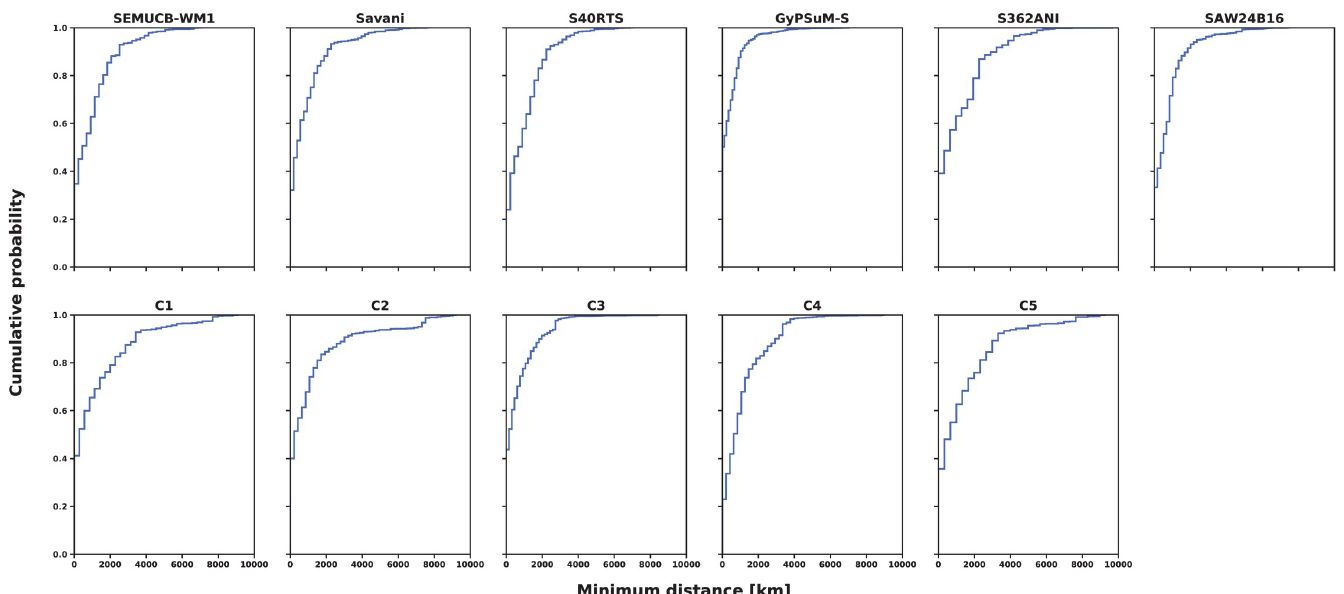
Fig 10. Distances between kimberlite eruption locations and high kimberlite potential areas. Empirical Distribution Functions (EDFs) of cumulative minimum distances from 640 Ma between reconstructed kimberlites (sampled in 20 Myr increments) and predicted high kimberlite potential areas for lithosphere thicker than 150 km [5] reconstructed using M21NNR, for all six tomographic models, and mantle flow models Cases 1–5 (that are based on M21NNR).